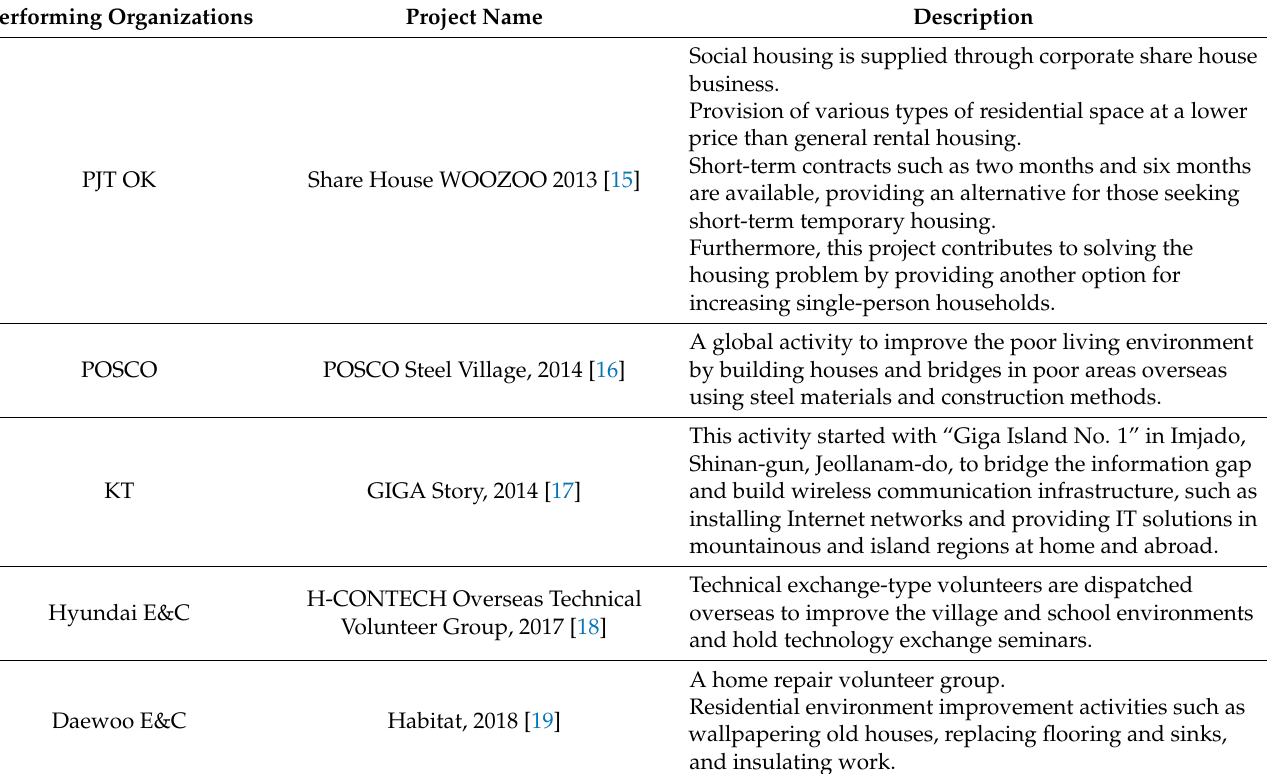
Table 3. Sustainability projects related to